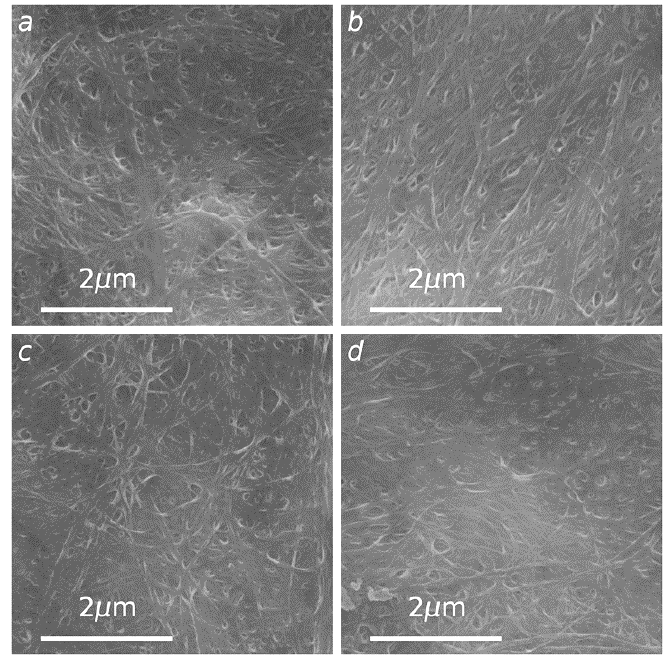
Figure 7. SEM images of cellulose films: E − ( a ), E+ ( b ), G − ( c ) and G+ ( d ).